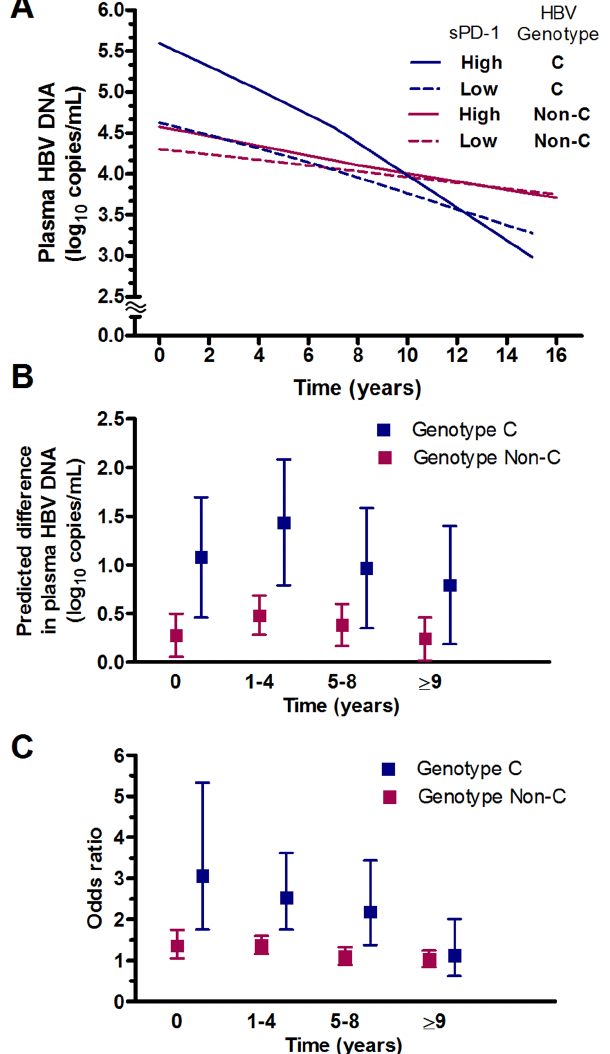
Figure 2. Effect of plasma sPD-1 on dynamics of HBV viral load across years of follow-up. (A) Plots of predicted mean plasma HBV-DNA levels derived from LOESS for each year of follow-up time according to different combinations of sPD-1 levels and HBV genotype. (B) Predicted difference (regression coefficient; squares) with 95% confidence interval (bars) in plasma HBV-DNA levels between high ( . 282 pg/mL) and low sPD-1 groups across time by HBV genotype. (C) Odds ratios (squares) and 95% confidence intervals (bars) of having a high viral load ( > 4.39 log copies/mL) for high vs. low sPD-1 across time by HBV